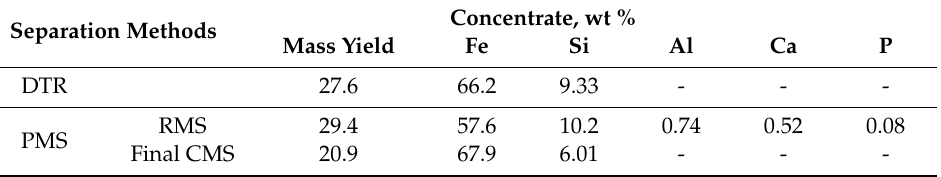
Table 4. PMS and DTR comparative studies Flowsheet 1 (Ore feed of P 80 = 45 µ m). CMS: cleaner magnetic separation, PMS: planar magnetic separator, RMS: rougher magnetic Table 3. The major element in the products from the classification unit.